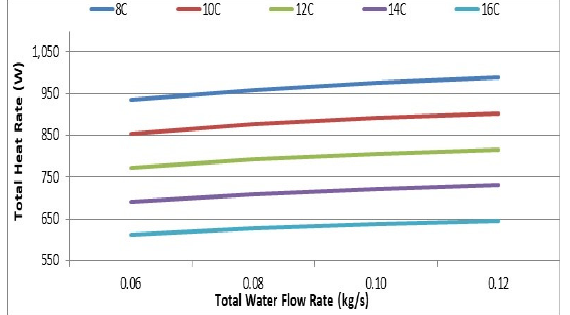
Fig. 9. The total heat rate of terminal units at 8, 10, 12, 14 and 16 °C water supply temperature and valve opening: Valve 1=50%, Valve 2=100 % and Valve 3=100%.